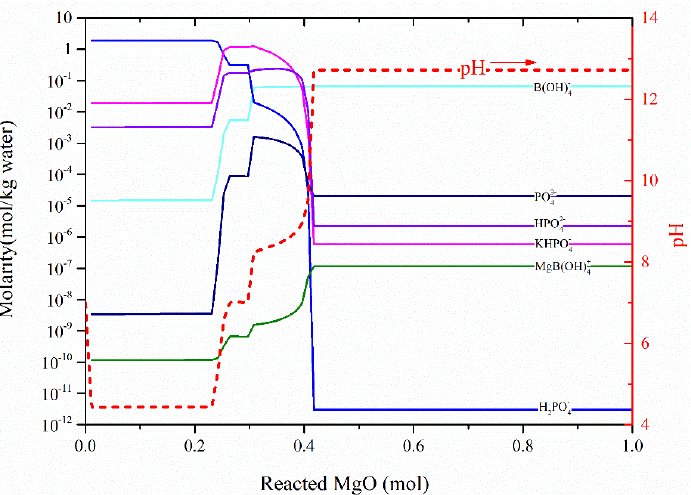
Figure 5. Evolution of the molarity of ions and pH value in MP2.7B0.25 solution with reacted amount of MgO.